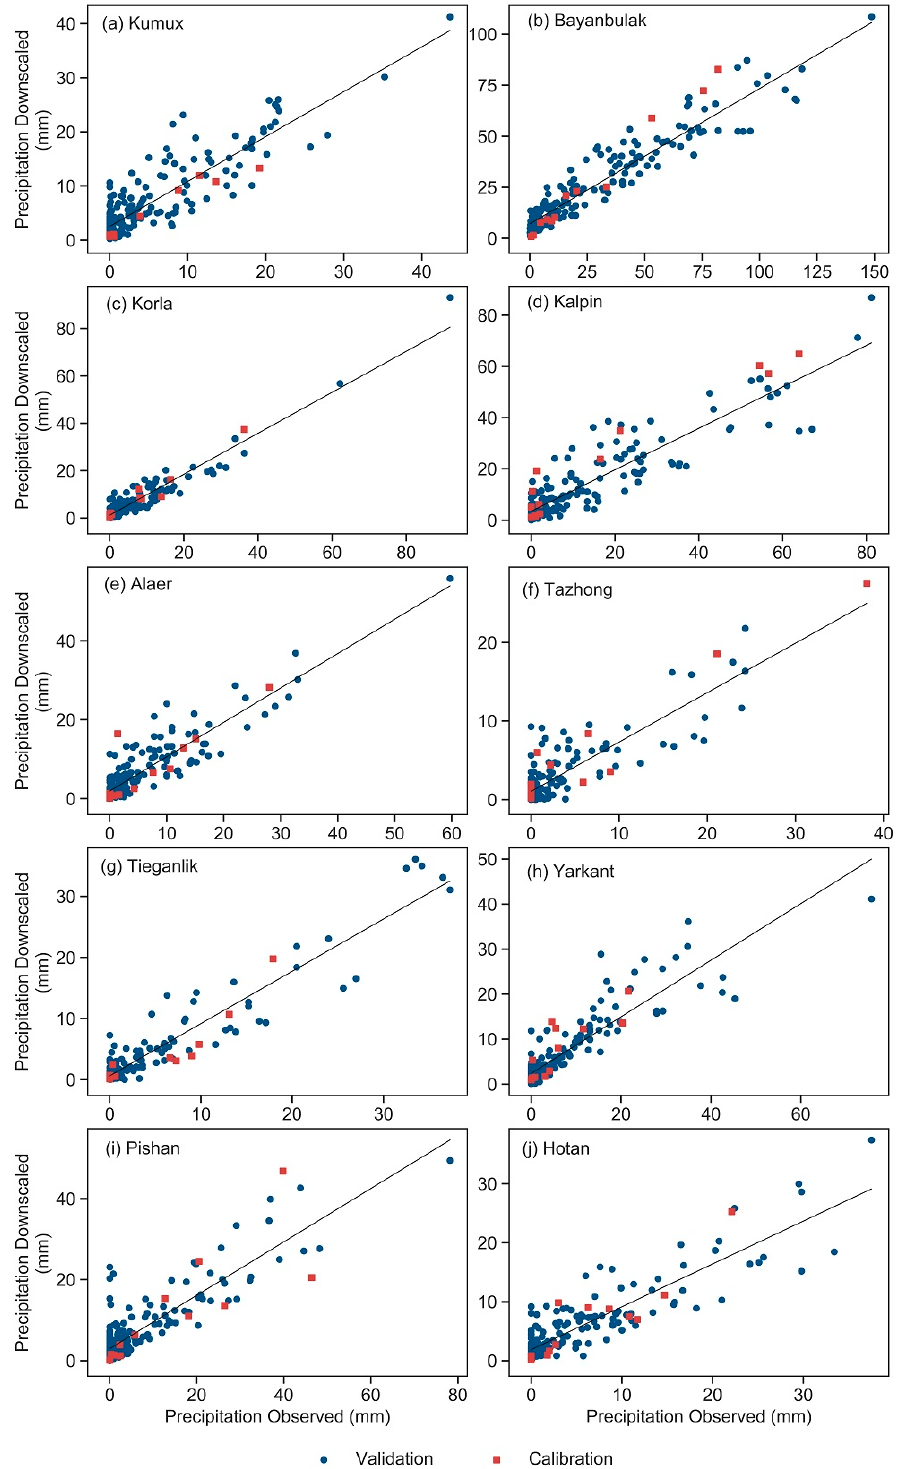
Figure 6. The scatter plots of calibration and validation for the observation data and downscaling data of each meteorological station. ( a – j ) are the scatter plots of Kumux, Bayanbulak, Korla, Kalpin,